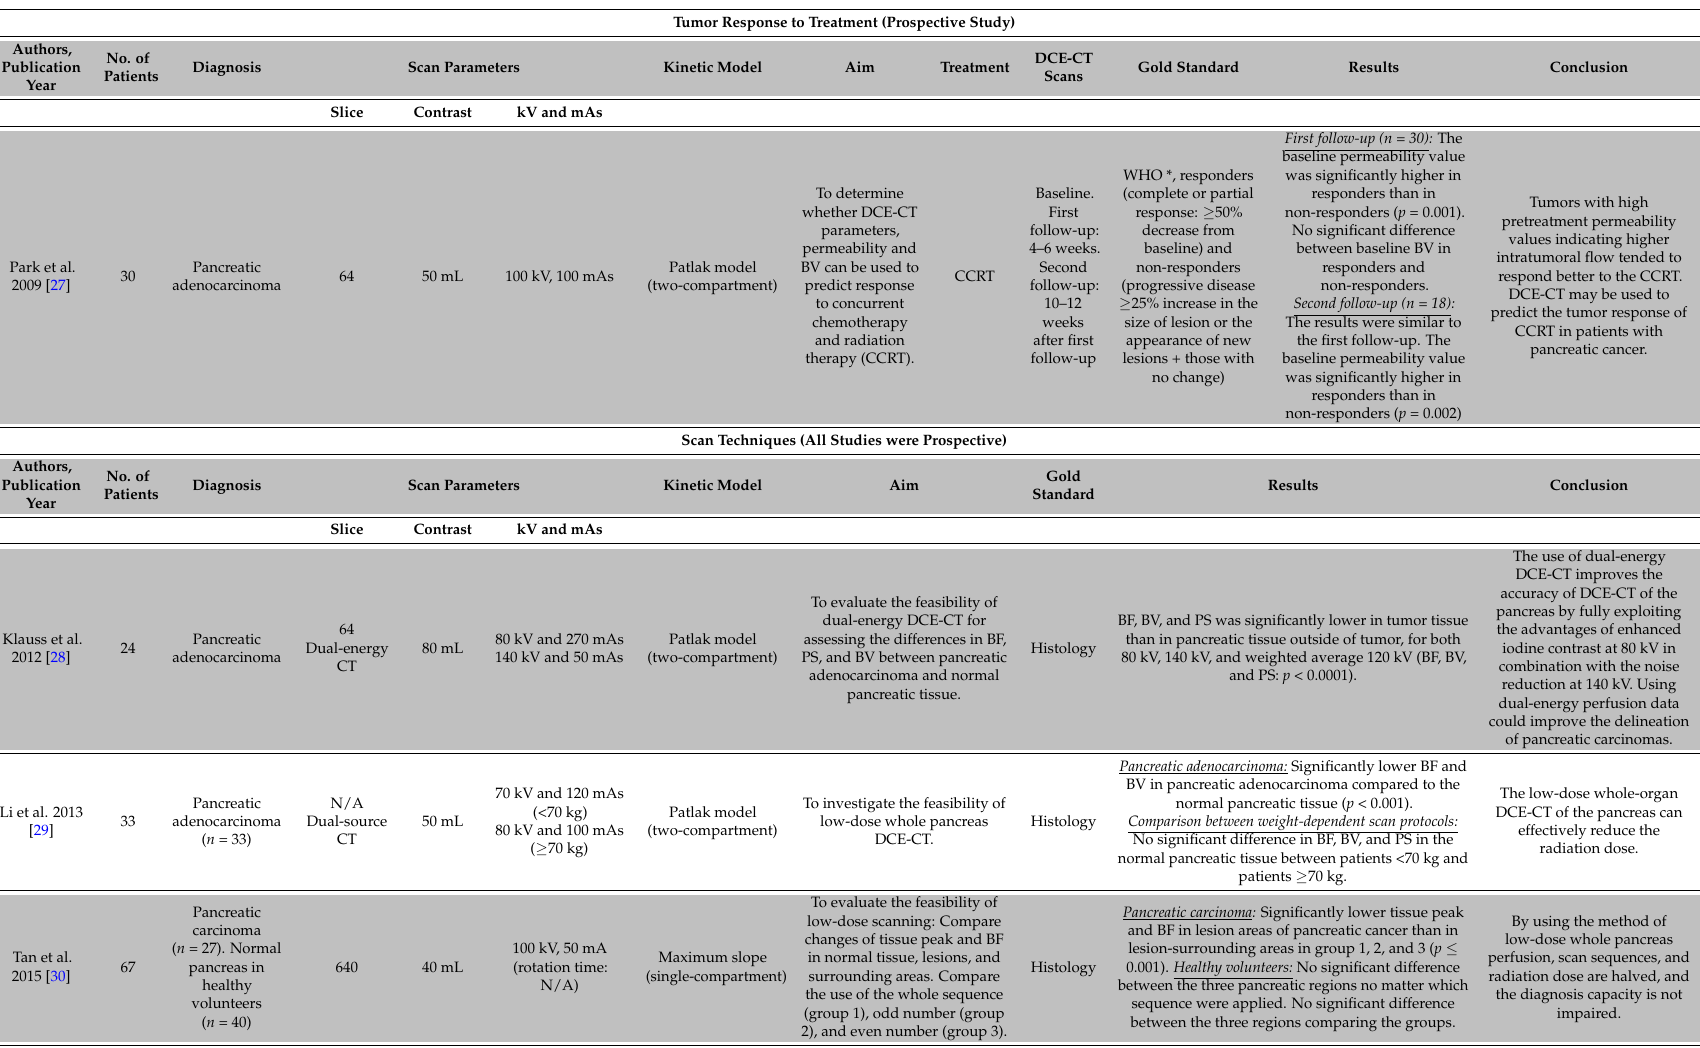
Table A2. Overview of included studies: Tumor response to treatment and scan